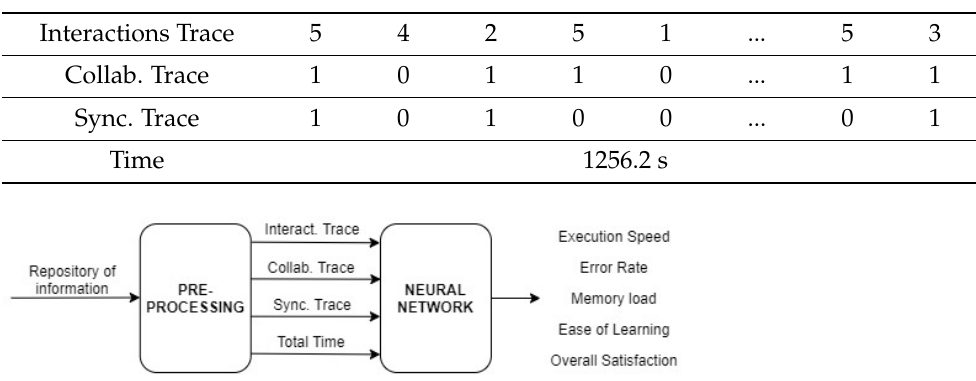
Table 1. Example of datum of a user.